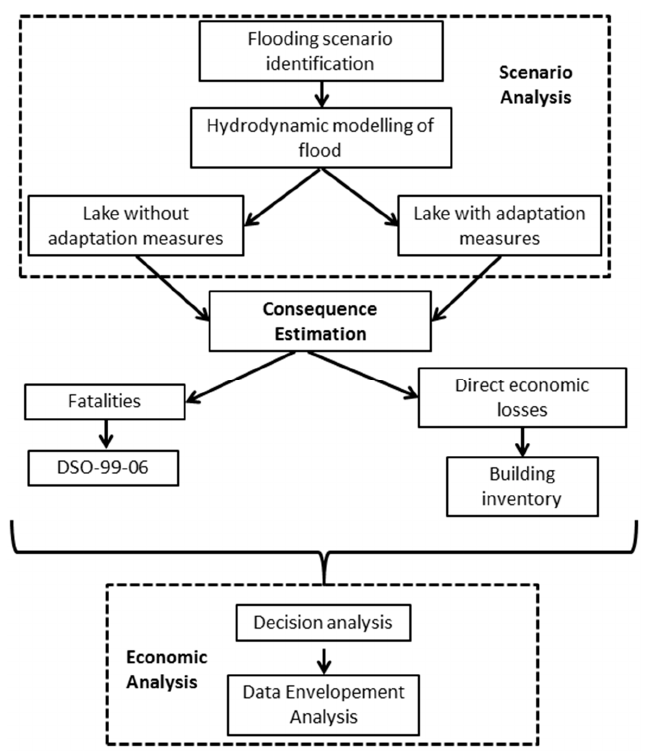
Figure 2. The glacial lake outburst flood (GLOF) risk management methodology.